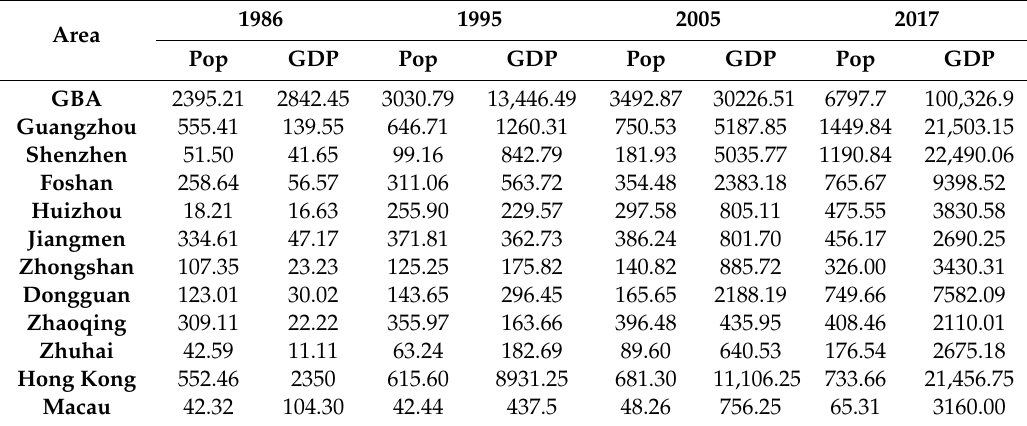
Table 1. Population (Pop) and Gross Domestic Product (GDP) of the GBA during 1986–2017. Area